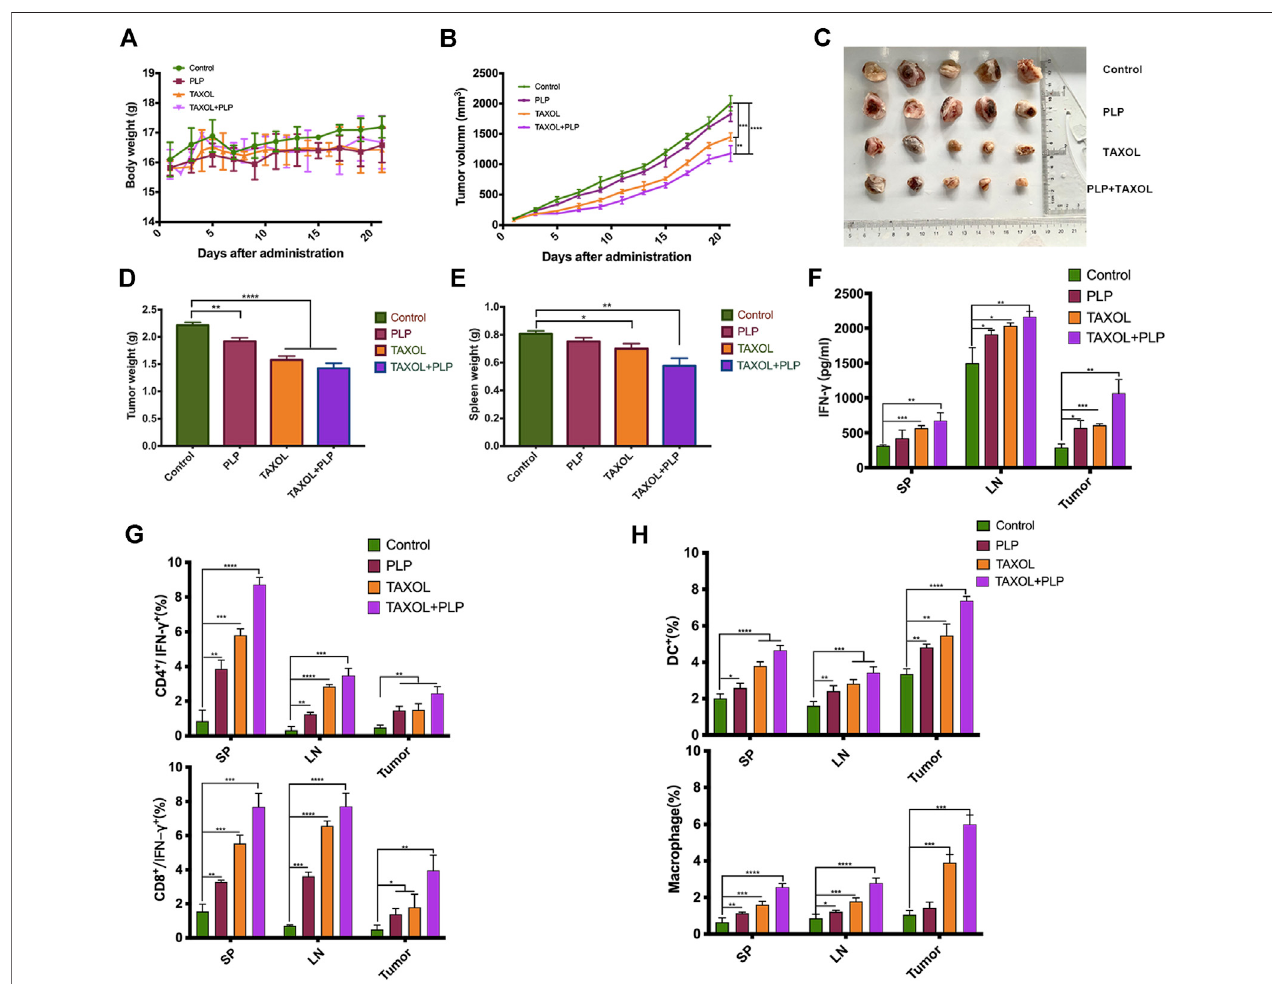
FIGURE 5 | PLP achieved therapeutic effects and improved immunity in the breast tumor model. (A) Mice body weight, (B) mean tumor growth curves given by tumor volume, (C) images of excised tumors from each mouse in each treatment group, (D) tumor weight, and (E) the spleen weight during the total immunotherapy course. (F) IFN- γ released from cellular supernatant of tumor-bearing mice in control, PLP, TAXOL ® , and TAXOL ® +PLP groups was tested by ELISA. (G) Phenotype analysis of CD4 + IFN- γ + T cells and CD8 + IFN- γ + T cells and (H) DCs and macrophages in mice spleen, inguinal lymph node, and tumors 22 days after 4T1 tumor cell inoculation. All values shown are the average values from three independent experiments ± SEM (n (cid:2) 5) (* p < 0.05, ** p < 0.01, and *** p < 0.001).